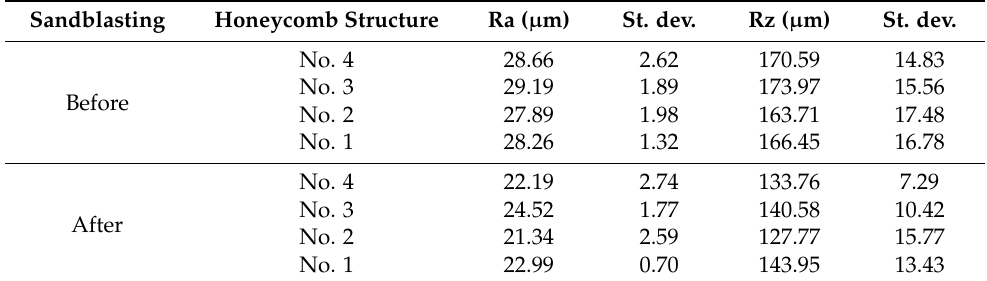
Figure 9. Geometrical quality control of specimen No. 4 before versus after heat treatment. Table 3. Results of the roughness tests of samples manufactured by the LENS technique without heat treatment.